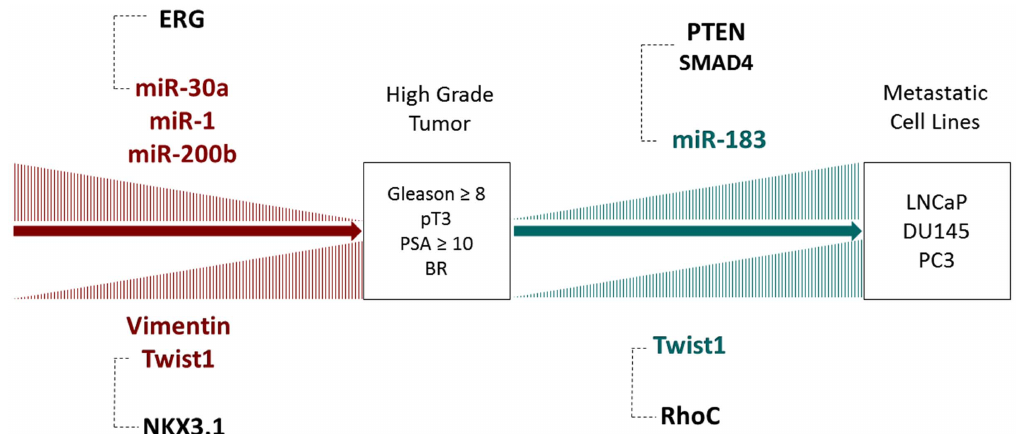
Figure 2. Main miRNAs and genes involved in epithelial-mesenchymal transition in prostate cancer. Expression levels of miRNAs 200b, 30a and 1 decrease when the tumor acquires high grade features, while expression levels of TWIST1 and Vimentin increase. When the tumor becomes metastatic, an increase in the expression levels of miR-183 and TWIST1 is observed. The dotted lines indicate the genes where these miRNAs or genes might act, based on previously published data. BR = Biochemical